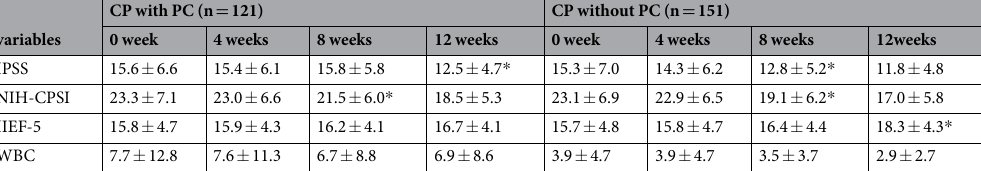
Table-3. Comparison of IPSS, NIH-CPSI and IIEF-5 scores in patients with and without prostatic calcification after treatment, CP = chronic prostatitis; PC = prostate calification; IPSS = international prostate symptom score; NIH-CPSI = National Institutes of Health Chronic Prostatitis Symptom Index; IIEF = International Index of Erectile Function WBC = white blood cell. The analysis of variance and paired t-test were used to analyze characteristics. Categorical variables were compared using the Pearson chi-square test. P < 0.05 was considered